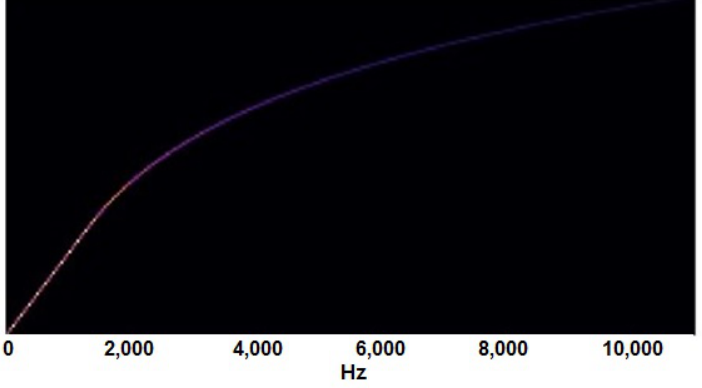
Figure 7. Mel filter bank used for creating